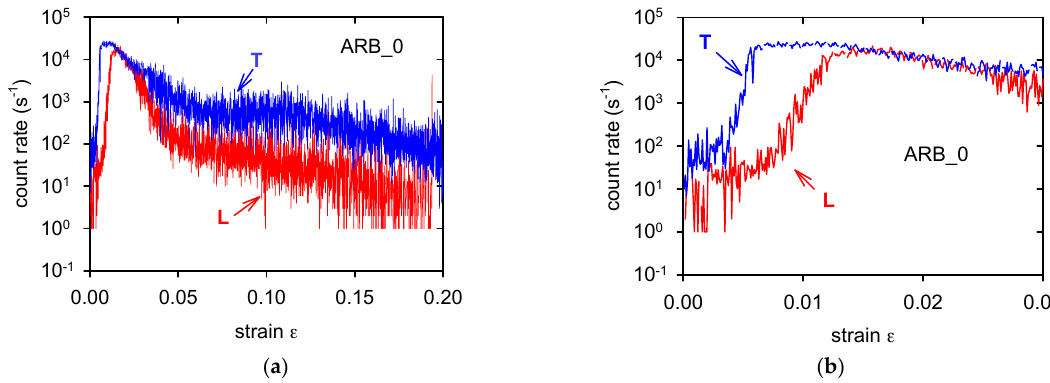
Figure 12. Acoustic emission rate measured during deformation of the ARB_0 samples ( a ). Beginning of the plastic deformation is recorded in ( b ).